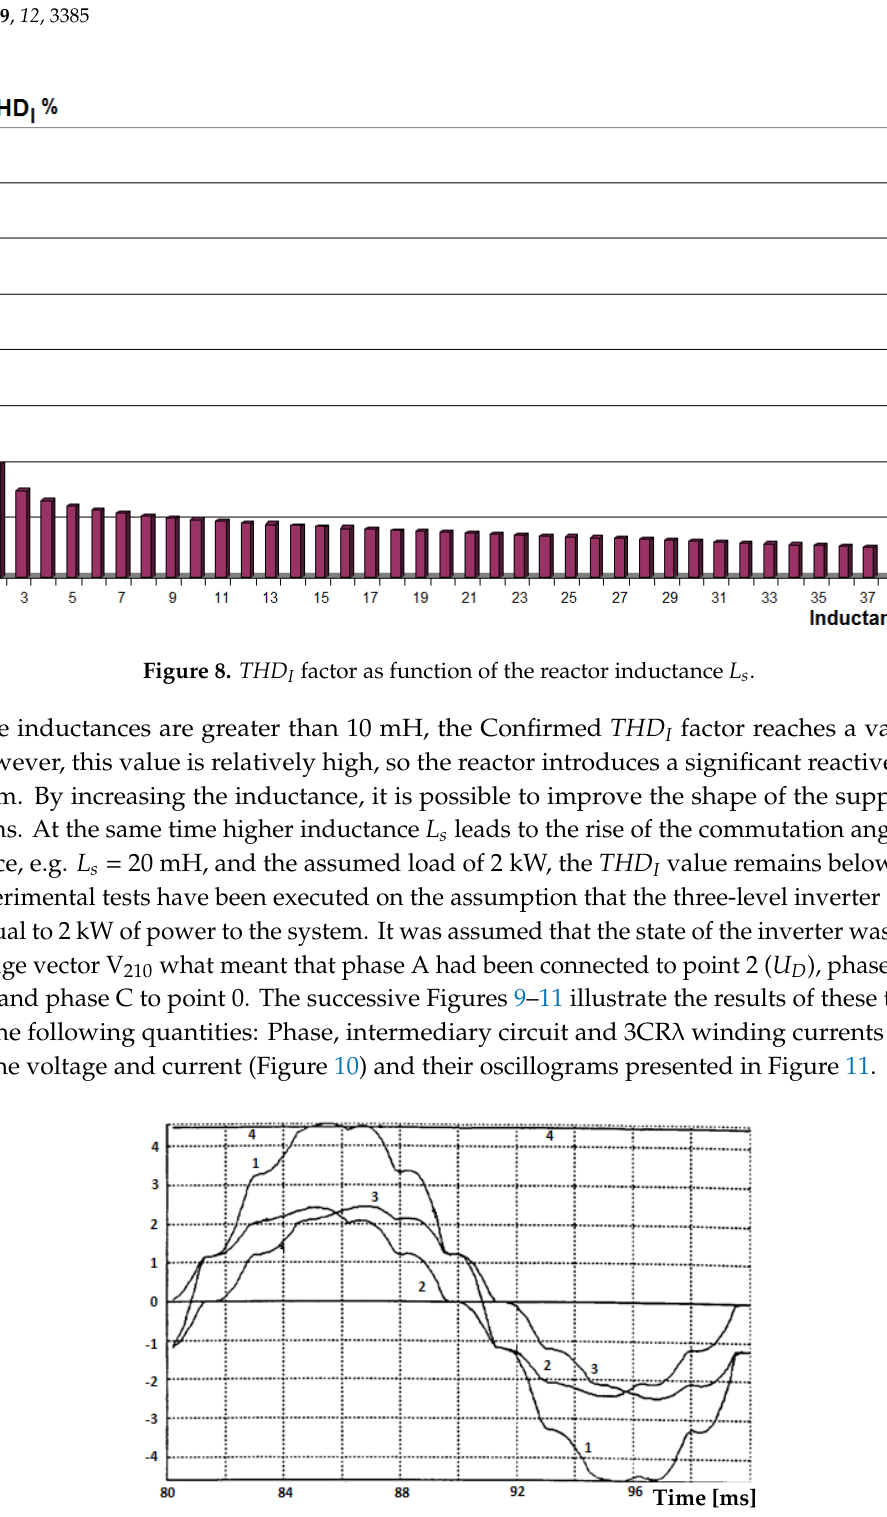
Figure 9. Current waveforms: 1-network phase current, 2 and 3-3CR λ winding currents i 1 R / 2 / , i 2 R / 3 / 4 - intermediary circuit current i d/ 4 / for the 2 kW load.